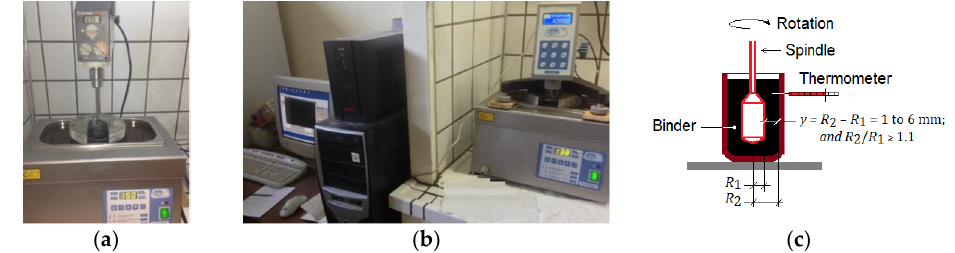
Figure 2. Steady-shear rheology: ( a ) wax/binder mixture; ( b ) viscometer; ( c ) operating mode.